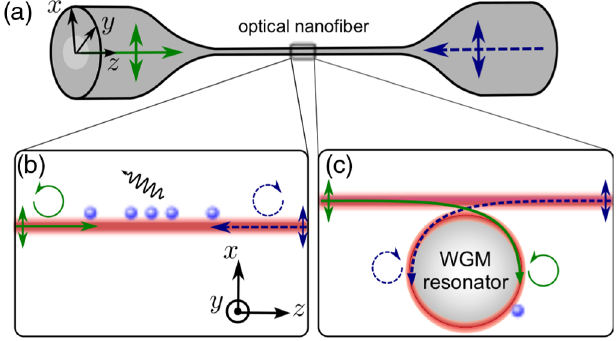
FIG. 2. Schematics of the demonstrated nonreciprocal wave- guides. (a) An optical nanofiber is realized as the waist of a tapered silica fiber. (b) Atoms are trapped in the vicinity of the nanofiber, interact with the evanescent field of the nanofiber- guided modes, and scatter light out of the nanofiber (wavy arrow) with a rate that depends on the direction of propagation. (c) A single atom is coupled to a whispering-gallery-mode (WGM) bottle microresonator. The atom-resonator coupling strength depends on the propagation direction of the field in the WGM resonator. The WGM resonator is coupled to the optical nanofiber via frustrated total internal